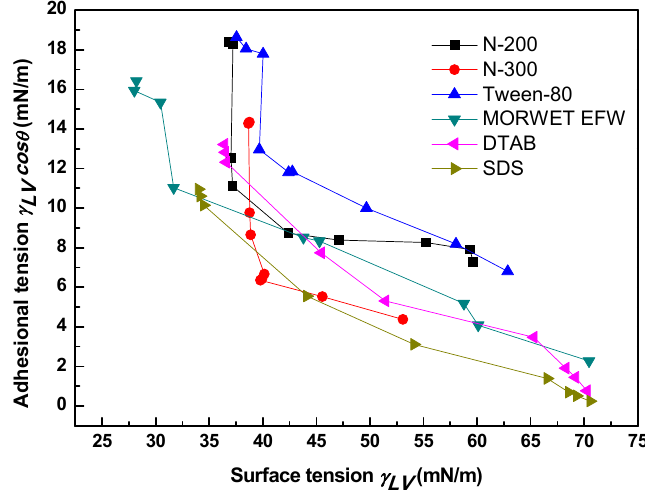
Figure 6. Relationship between surface tension ( γ LV ) and adhesion tension ( γ LV cos θ ) on tea leaf surfaces. Table 4. Slope and coe ffi cient values obtained by the relationship between the surface tension and adhesion tension.